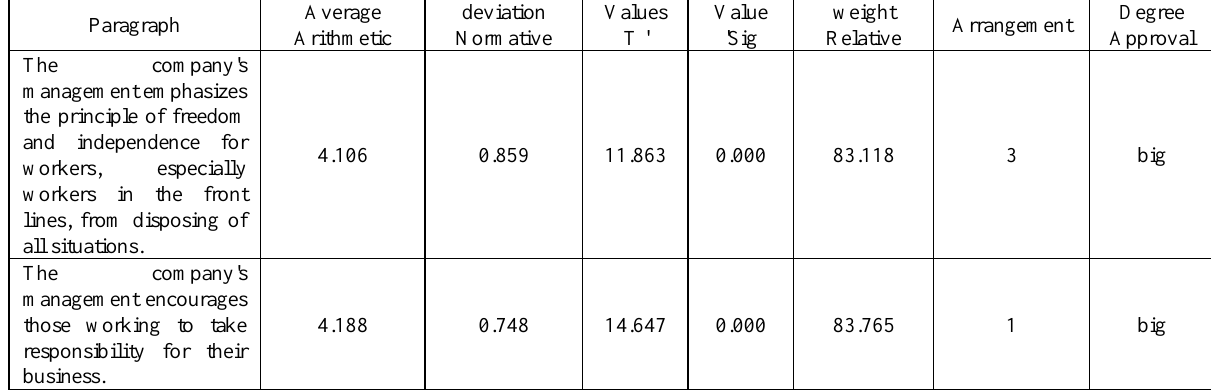
Table 14. Analysis of the paragraphs of the axis of freedom and